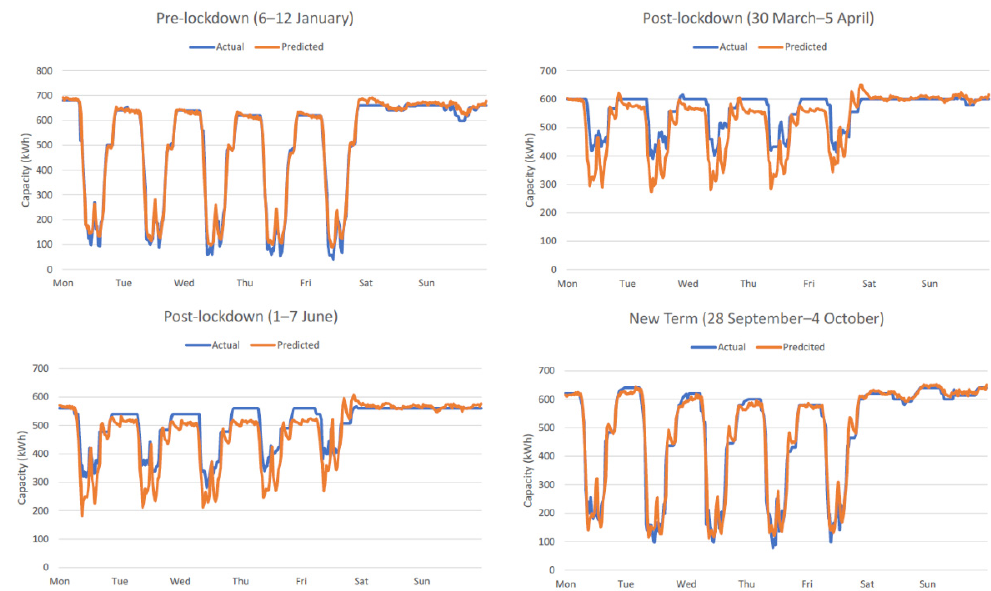
Figure 8. Actual vs. predicted capacity using the model without online machine learning for 4 sample weeks during 2020.